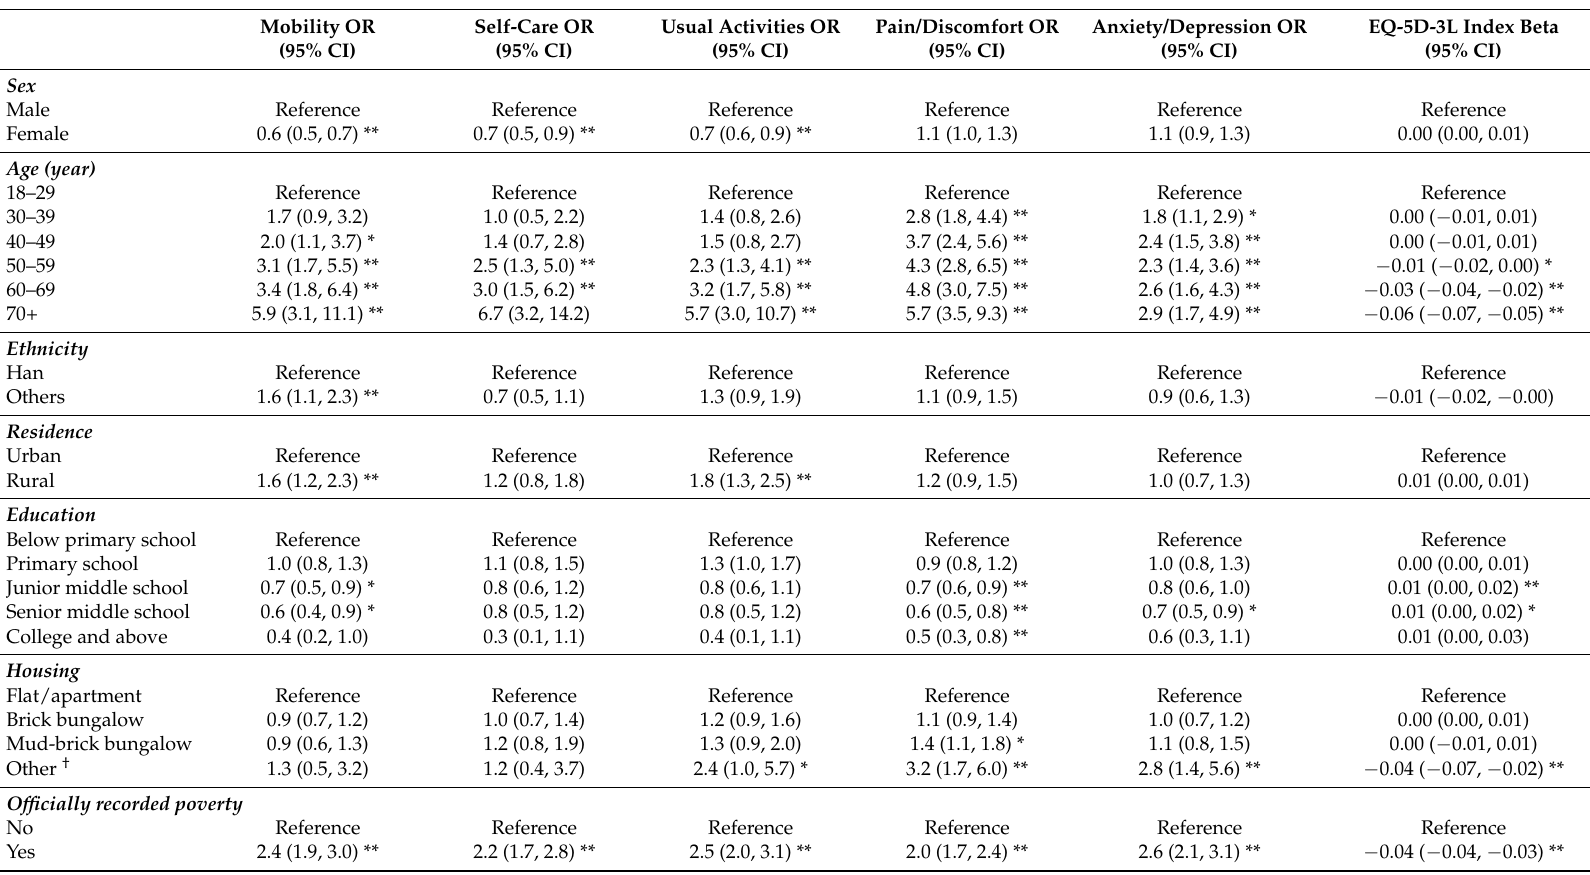
Table 3. Associations between characteristics and EQ-5D-3L index and its health problems reported in five